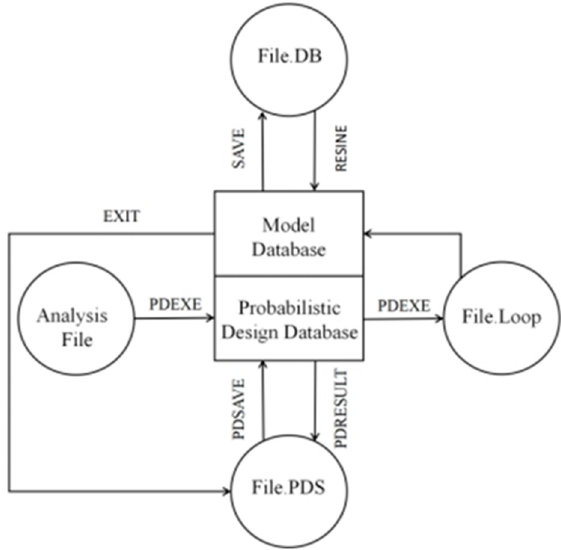
Figure 4. Flow chart of data processing for reliability analysis.